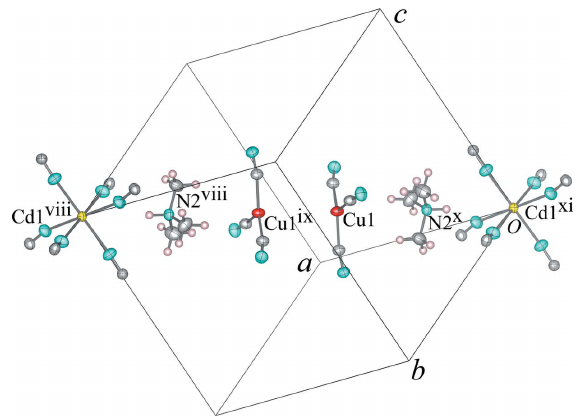
Figure 3 An arrangement of the Cd II (octahedral coordination sphere), Cu I (trigonal-planar coordination sphere) and (CH 3 ) 3 NH + ions on the threefold rotation axis running along the diagonal line of the unit cell. The distance between Cu1 and Cu1 ix is 3.9095 (5) A˚ . [Symmetry codes: (viii) x + 1 , (cid:2) y + 3 , 1 (cid:2) z ; (ix) 1 (cid:2) x , 1 (cid:2) y , 1 (cid:2) z ; ( x ) x (cid:2) 1 2 2 x (cid:2) 1 , (cid:2) y + 1 , (cid:2) z .] Figure 1 2 2 , – x + 1, y (cid:2) 1 ; (ii) (cid:2) y + 1, 2 2 , x , (cid:2) y + 1 ; (v) y , (cid:2) z + 1 , x (cid:2) 1 ; 2 2 2 2